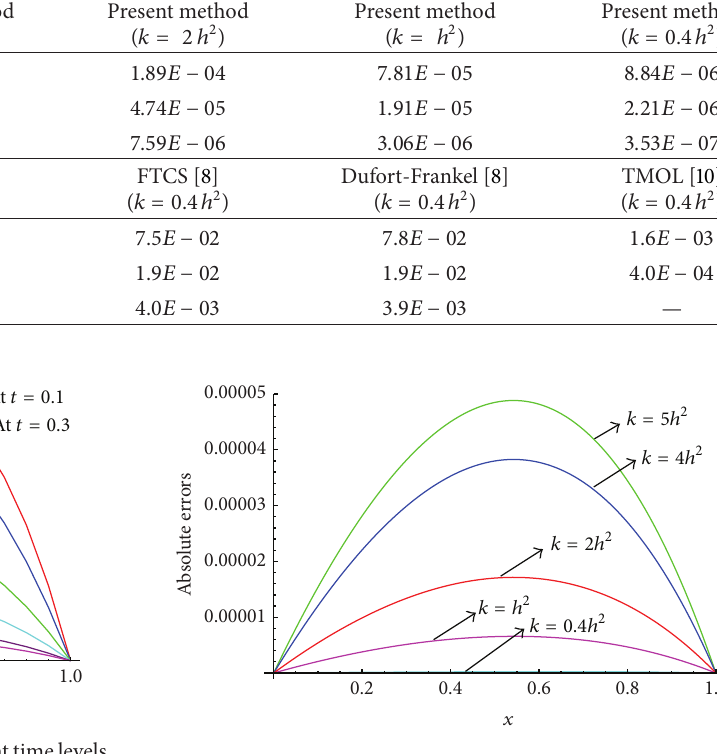
Figure 3: Absolute errors of numerical values at different time levels for Example 2 by using ℎ = 0.05 and 𝑘 = 0.001 .